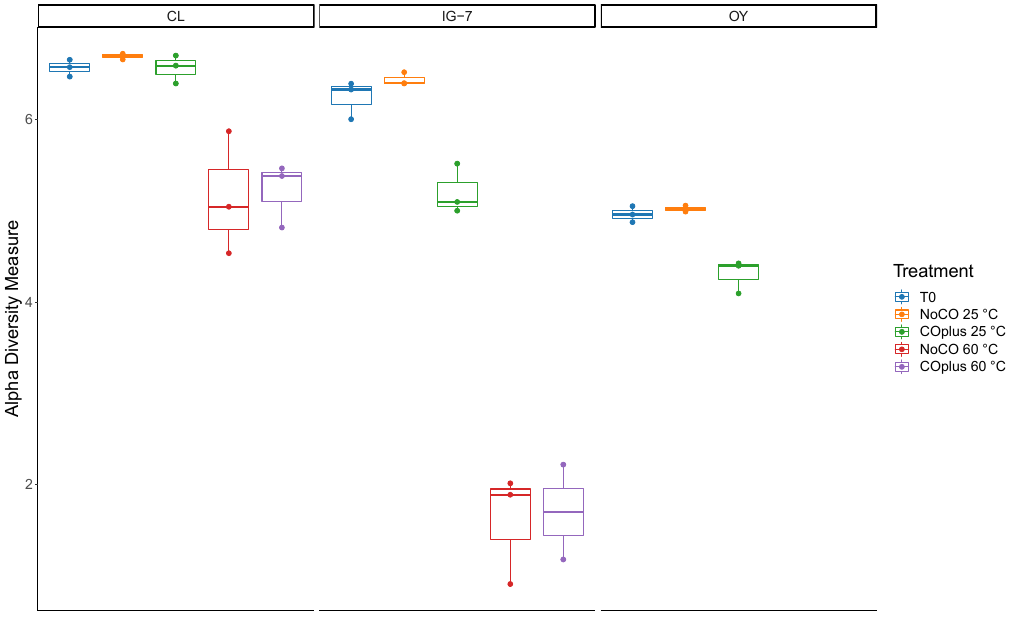
Figure 5. Shannon index for all treatments for sites CL, IG-7, and OY. Bars in the box and whisker plots represent median values.